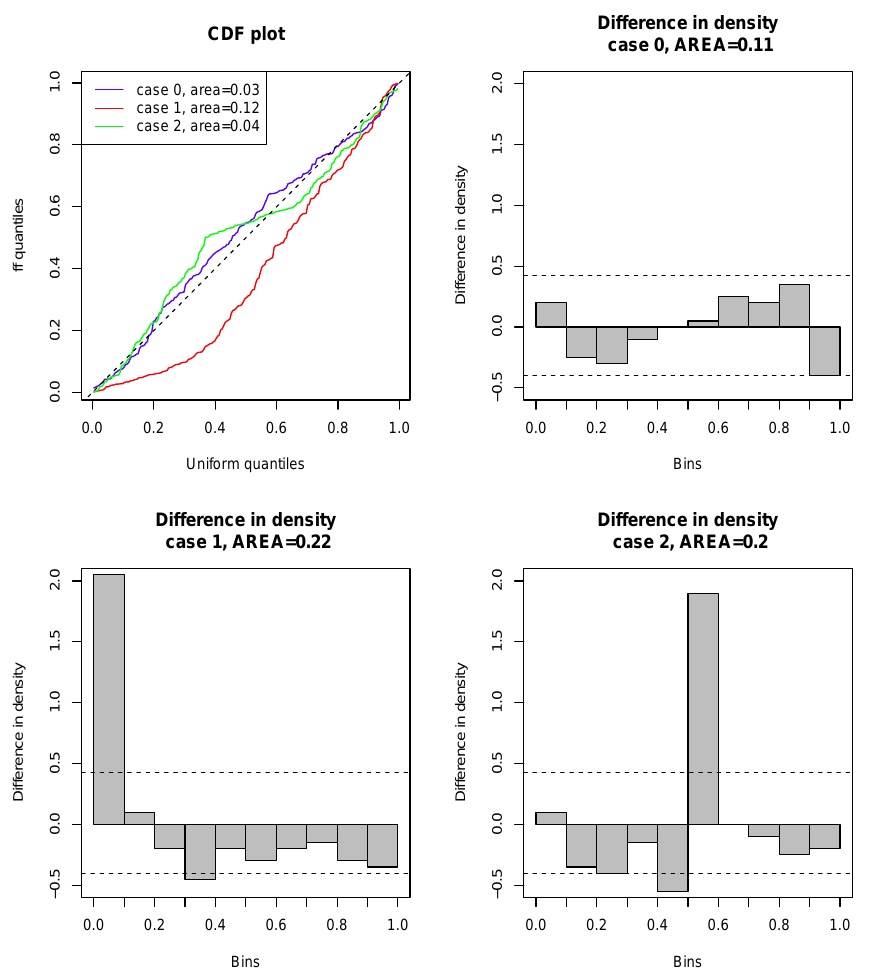
Figure 2. Graphical tools for model evaluation based on FF scores, for three simulated series of length 200. The CDF case (upper left) is the method of Renard et al. (2013). The density case (upper right and lower panels) is the alternative method comparing densities (Eq. 10). The dotted horizontal lines show the 95% confidence interval for uniform variates on ( 0 , 1 ) of length 200, based on 1000